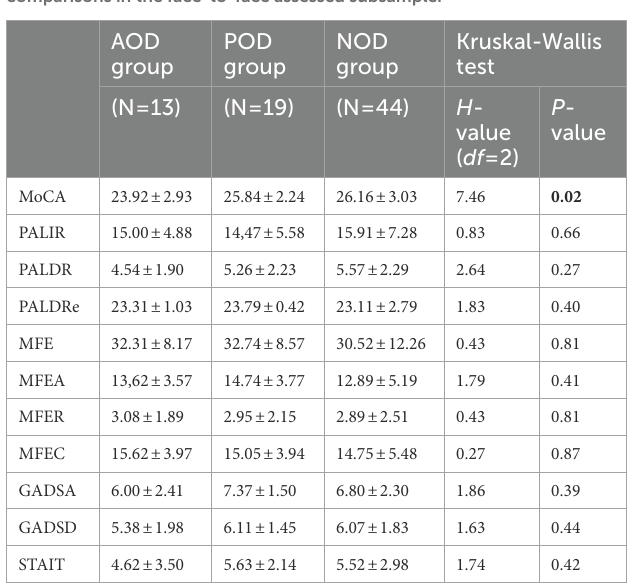
of each multiple regression is shown. The significant associations between scores of the MFE and main predictors are described